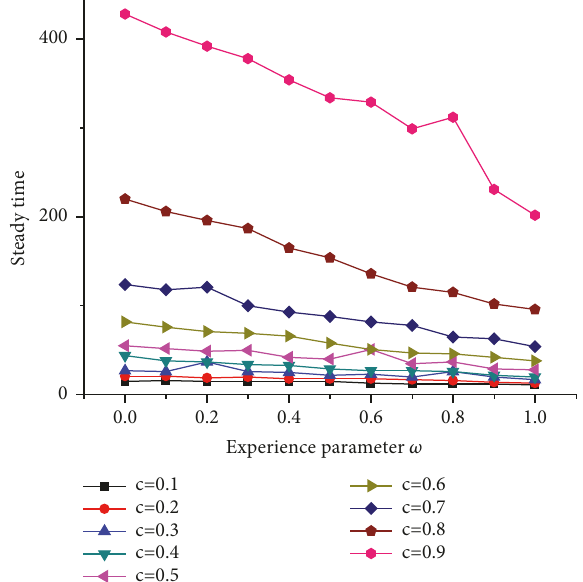
Figure 6: Steady time with different cognitive parameters ( 𝑐 ) and experience parameters ( 𝜔 ) and a constant confidence threshold of